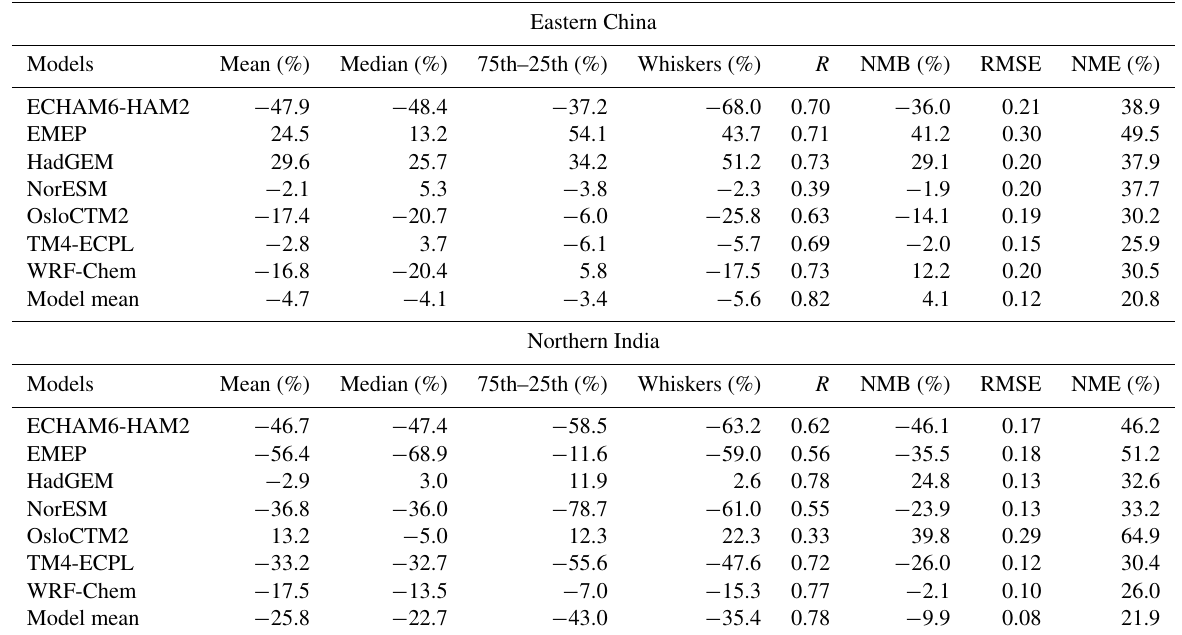
Table 6. Deviation (in percent) of model results from MODIS AODs observations based on spatial variations: mean, median, differ- ences between the 75th and 25th percentiles and whiskers. For each parameter, the value corresponds to the following relationship: AOD model − AOD MODIS , and statistical parameters (correlation coefficient R , normalized mean bias NMB, root mean square error RMSE and AOD MODIS normalized mean error NME) are calculated using monthly mean AODs over eastern China and northern India in August and September